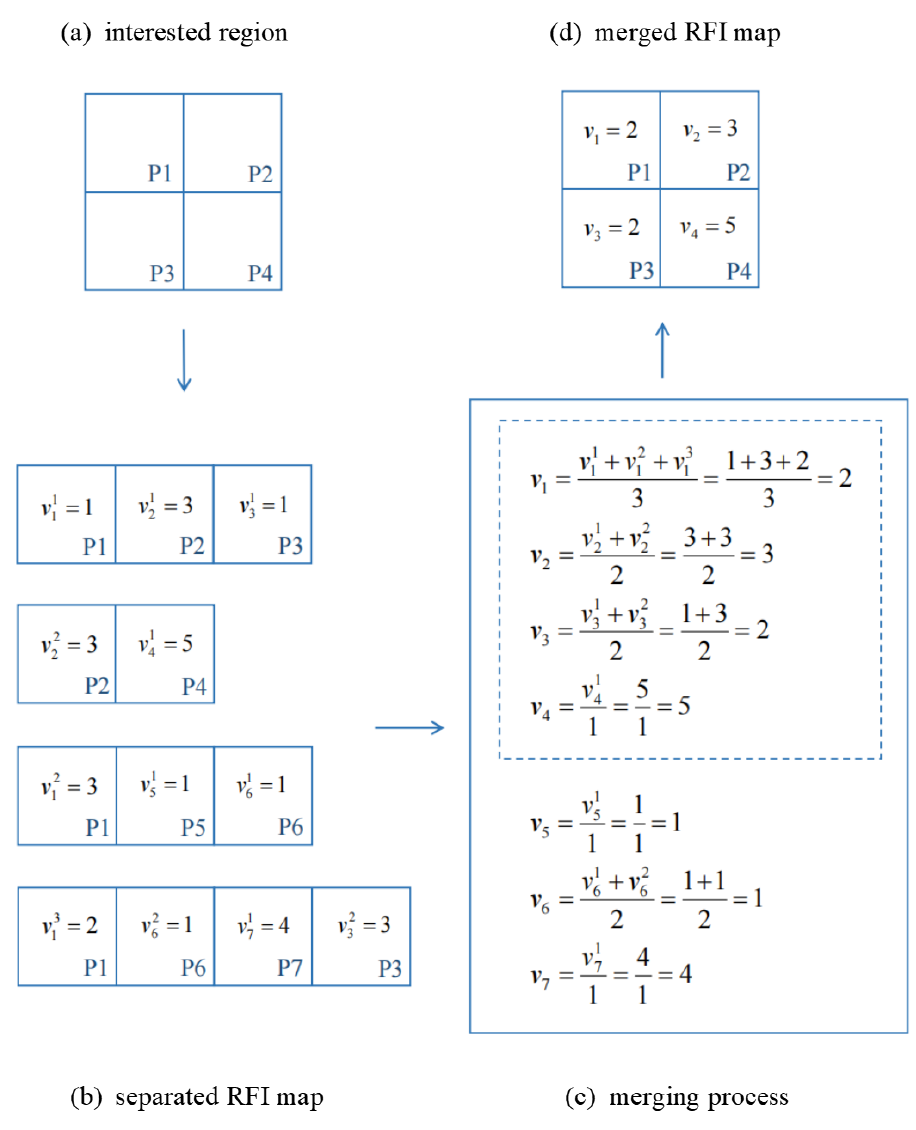
Figure 5. ( a ) Supposing there are four geographic points, P1, P2, P3, P4, in the region of interest. ( b ) The element v n represents the RFI statistic of the corresponding geographic point P n , and v n and P n correspond one-to-one. ( c ) In the merging process, all the RFI statistics are summed up by a different element v (or point P). For example, P1 exists in the first, the third, and the fourth separated maps, so the three v 1 are added together, and the process is the same for other elements. Then, the sum is divided by the point’s times of occurrence, so the denominator is 3 in the case of v 1 . ( d ) In this demonstration, v 5 , v 6 , and v 7 are not in the area of interest and will be dropped in the final merged RFI